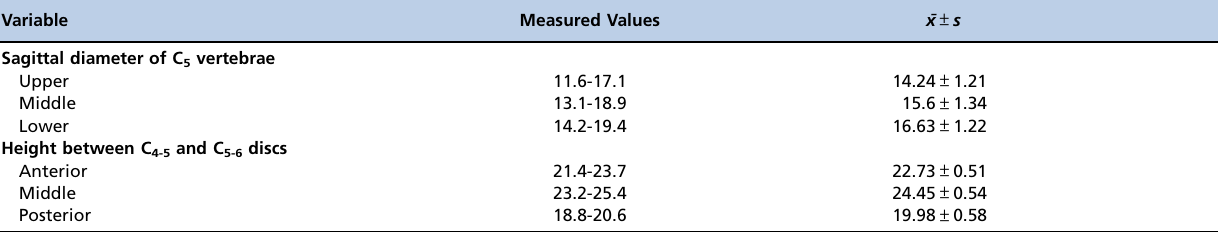
Table 1 - C 5 Vertebrae and C 4-5 and C 5-6 Disc Measurements